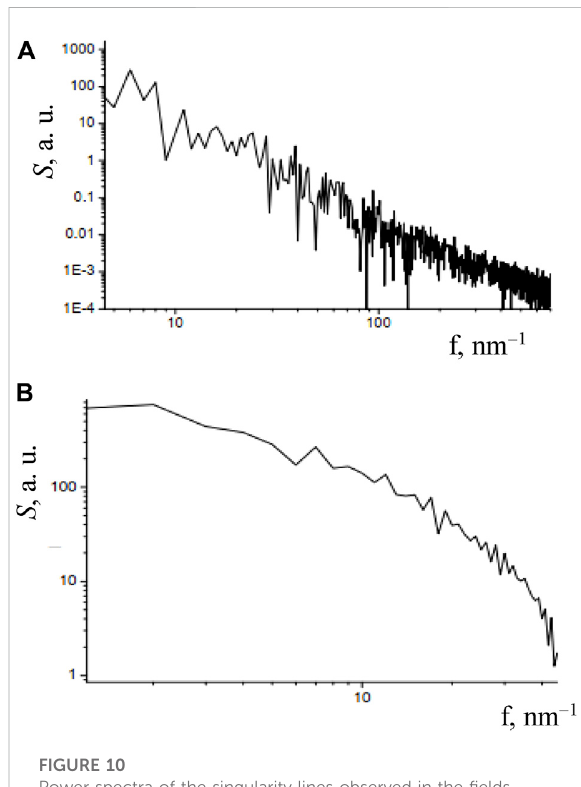
FIGURE 10 Power spectra of the singularity lines observed in the fi elds scattered by (A) fractal (see Figure 9B) and (B) random non-fractal (see Figure 9A)